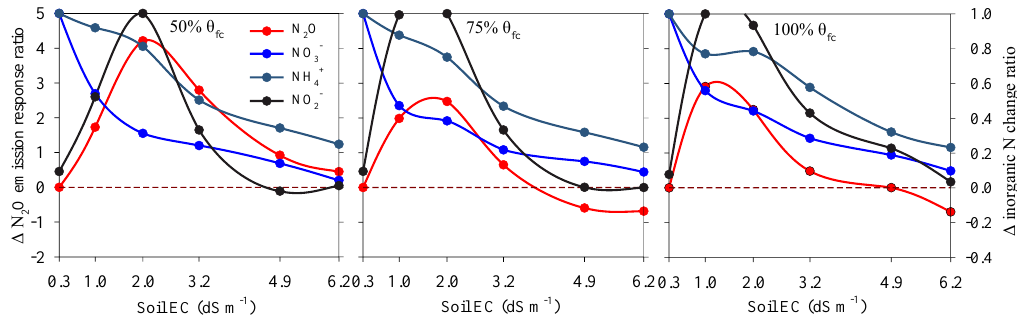
Figure 6. The response of cumulative N 2 O emissions, NH 4 + -N consumption, NO 2 − -N accumulation and NO 3 − -N accumulation to soil salinity at three soil moisture levels. N 2 O emission response ratio to soil salinity was calculated as the relative increment in N 2 O emission compared with the soil at S1 salinity level. ∆ inorganic N change ratio including ∆ NH 4 + -N consumption ratio, ∆ NO 2 − -N accumulation ratio and ∆ NO 3 − -N accumulation ratio, were calculated as the relative decrement or increment of respective concentration under each salinity level compared with the maximum value of that among six salinity levels.